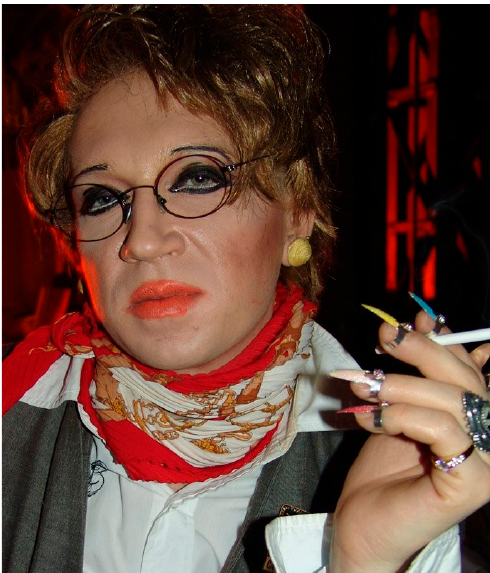
Figure 11. Vlad Mamyshev-Monroe. From the series “Valentina Matvienko” (2005), https://vmmf.org/series/view?id=30#work-series-30-2 (accessed on 11 September 2022).